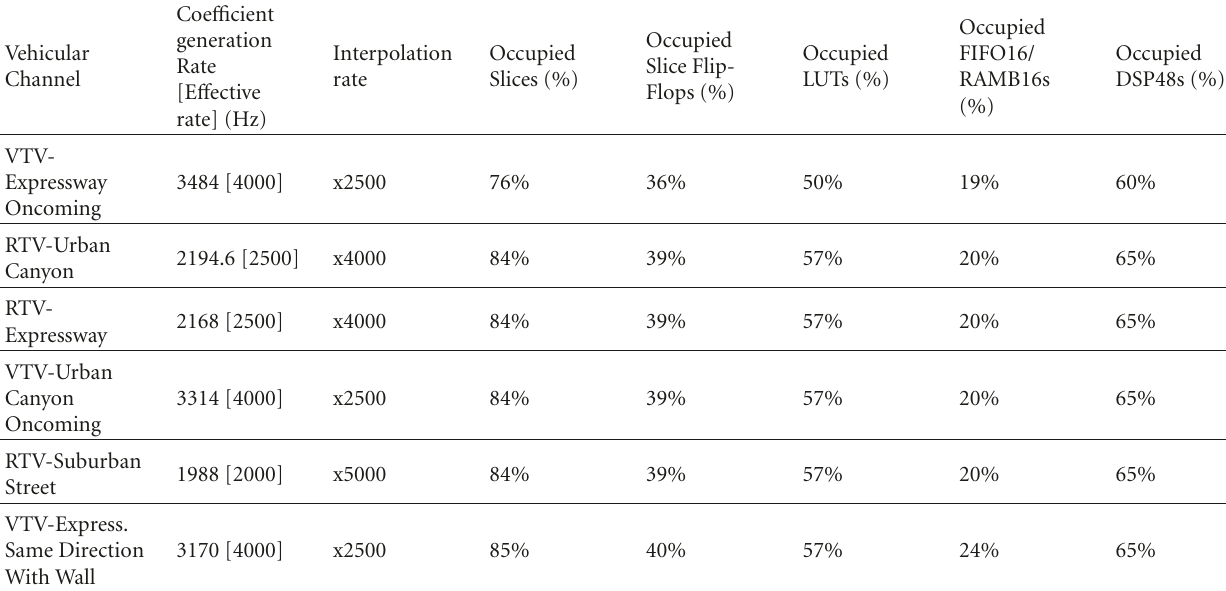
Table 2: General parameters and resources occupied by the vehicular channel